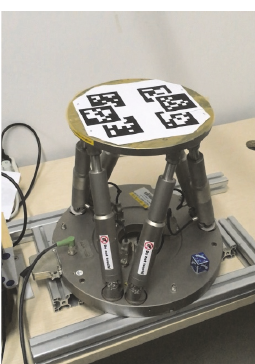
Figure 9: H-840 6-Axis Hexapod. An ultra-high precision cloud terrace with flexible